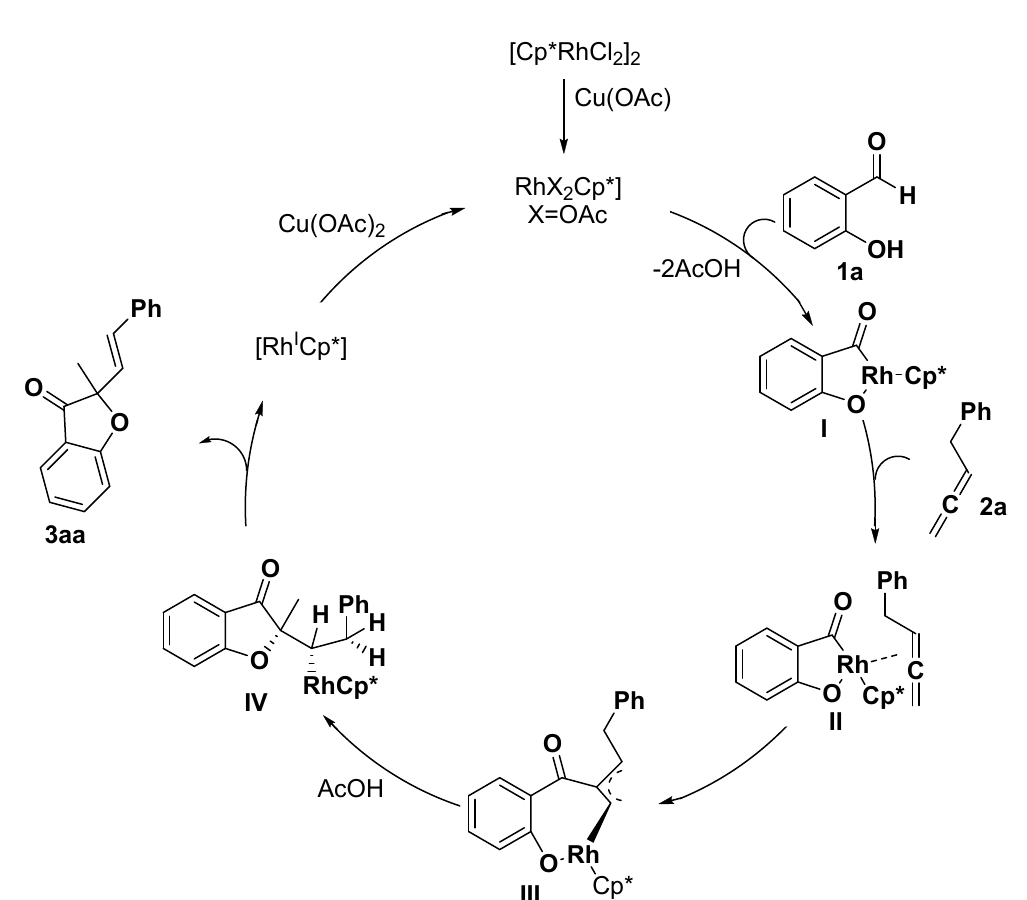
Scheme 2. Proposed reaction mechanism.